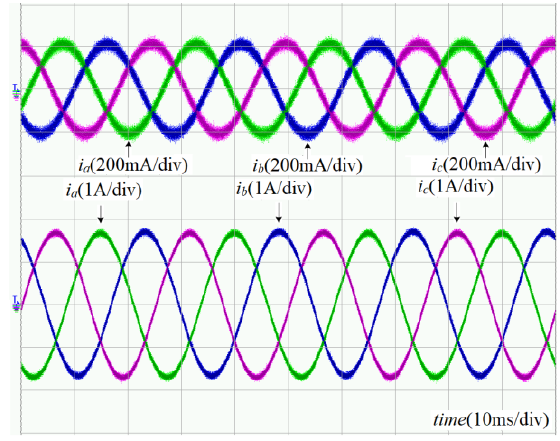
Figure 18. Three-phase currents of the motor.